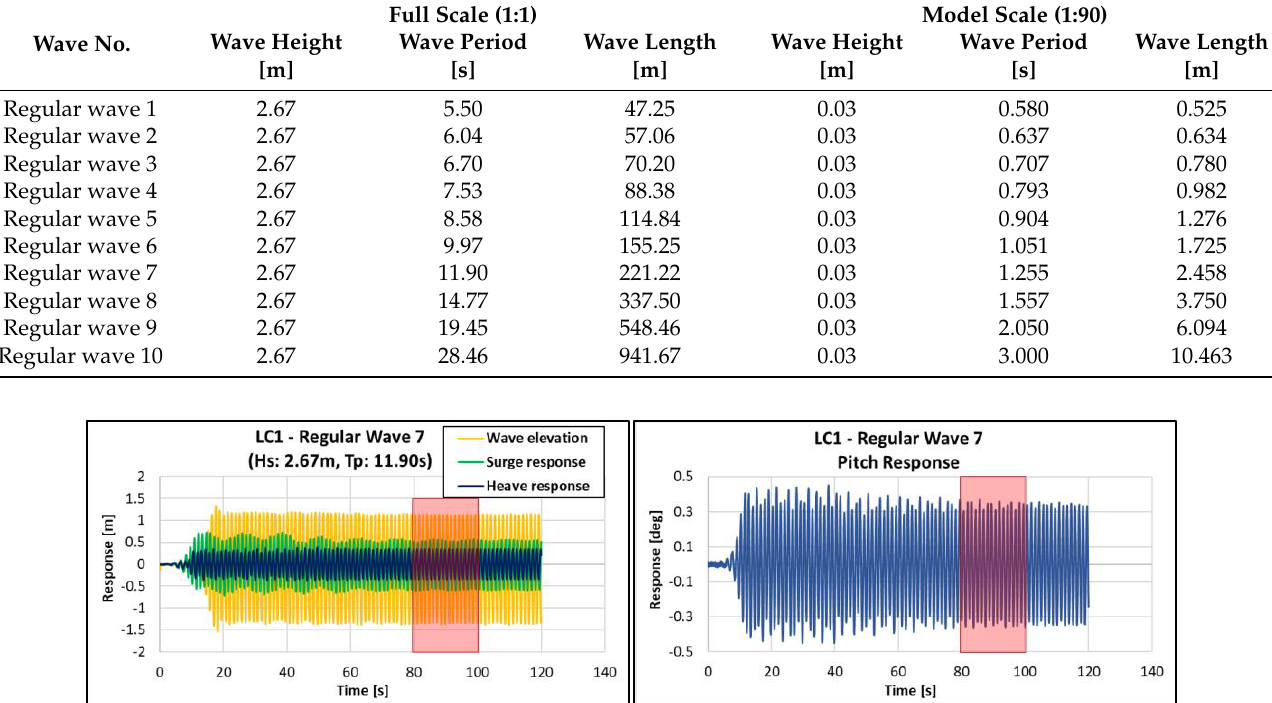
Table 8. LC1 and LC2, Regular wave conditions for model test.